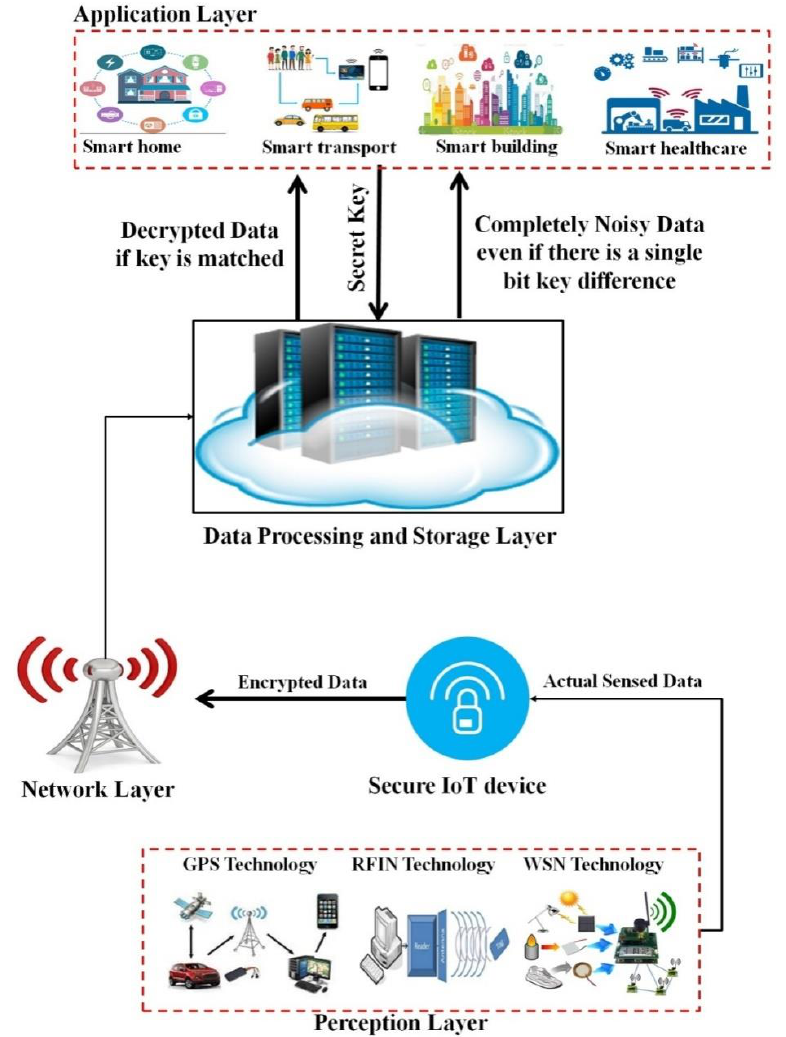
Figure 1. Proposed 6G-enabled secure IOT network [10] .